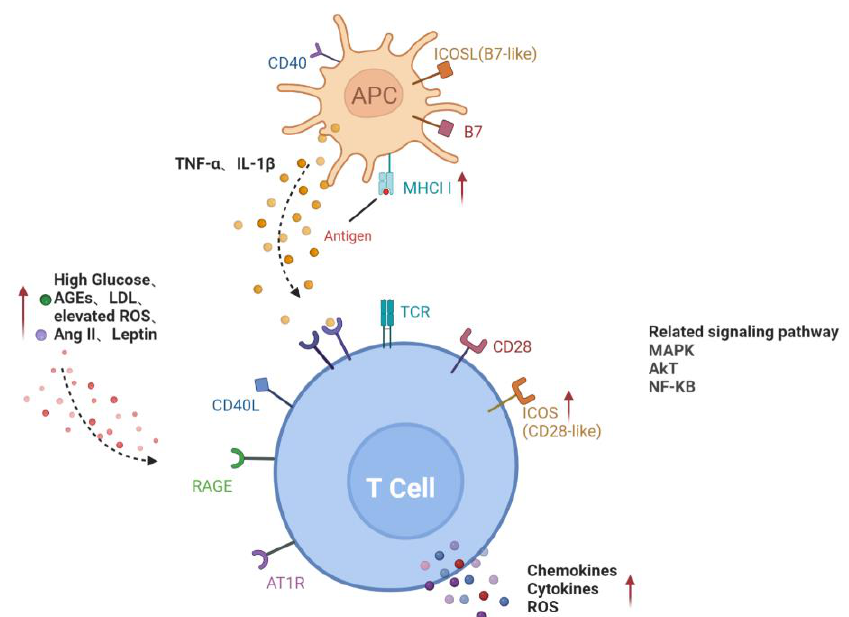
Figure 1. Activation pathways of T lymphocytes in diabetes. Direct contact between APC and T cells through MHCII and co-stimulators on the cell surface; increased glucose, AGEs, LDL, ROS, Ang II and leptin in diabetic microenvironment or cytokines such as TNF- α and IL-1 β secreted by APC activate T cells, forming the paracrine pathway. Red arrows represent the upregulation of gene expression or increase of risk factors in diabetes. Black dotted arrows stand for cellular interaction through paracrine pathway. AGEs, advanced glycation end-products; AT1R, angiotensin II type 1 receptor; ICAM-1, intercellular adhesion molecule-1; LDL, low-density lipoprotein; RAGE, receptor for advanced glycation end products; ROS, reactive oxygen species; ICOSL, inducible co-stimulatory molecule ligand; MHCII, major histocompatibility complex class II; MAPK, mitogen-activated protein kinase; AKT, v-akt murine thymoma viral oncogene homologue; NF-KB, nuclear factor-kappaB.